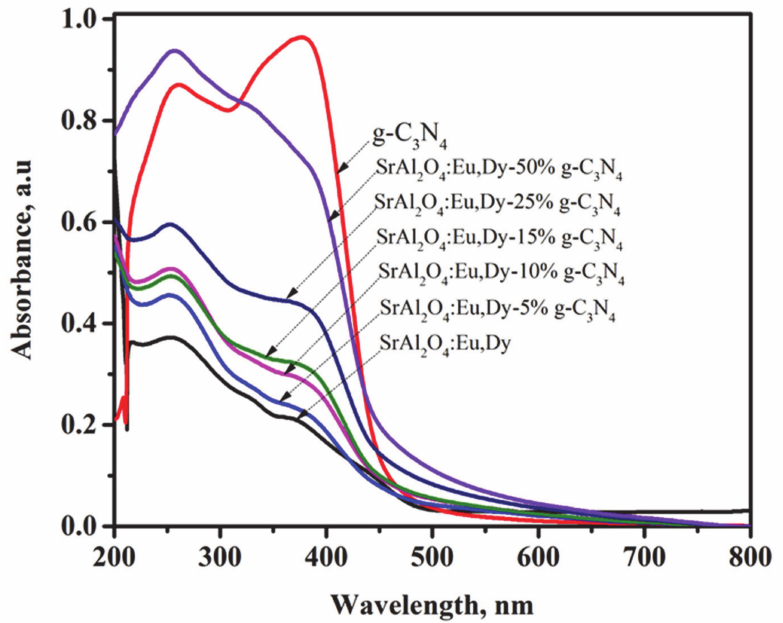
Figure 5. Di ff use reflectance absorption spectra for g-C 3 N 4 and SrAl 2 O 4 :Eu,Dy hybrid